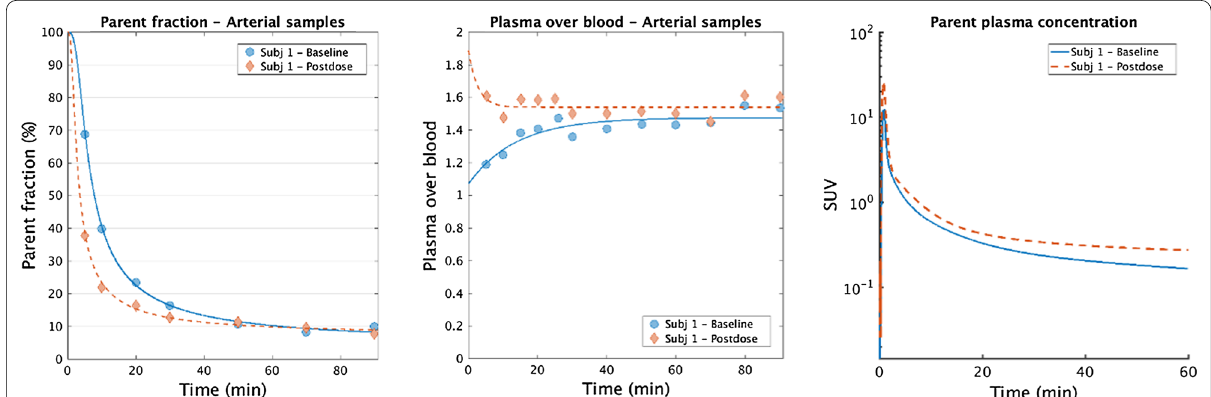
Fig. 3 The percentage of parent [ 11 C]PBR28 contributing to the total radioactivity ( a ) and the plasma over blood ratio ( b ) in arterial blood that were used to generate the plasma [ 11 C]PBR28 input function for the full duration of the scan ( c ) for subject 1 at baseline and post-block